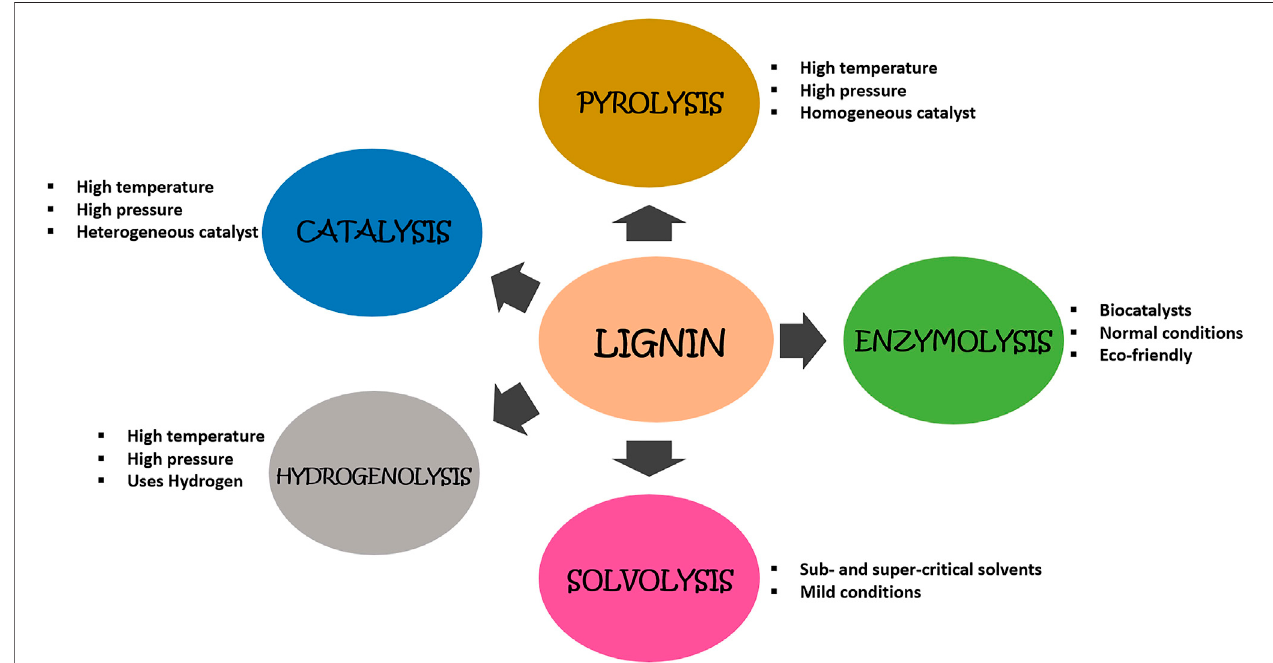
FIGURE 2 | Diagrammatic representation of different methods employed to degrade lignin biopolymer.